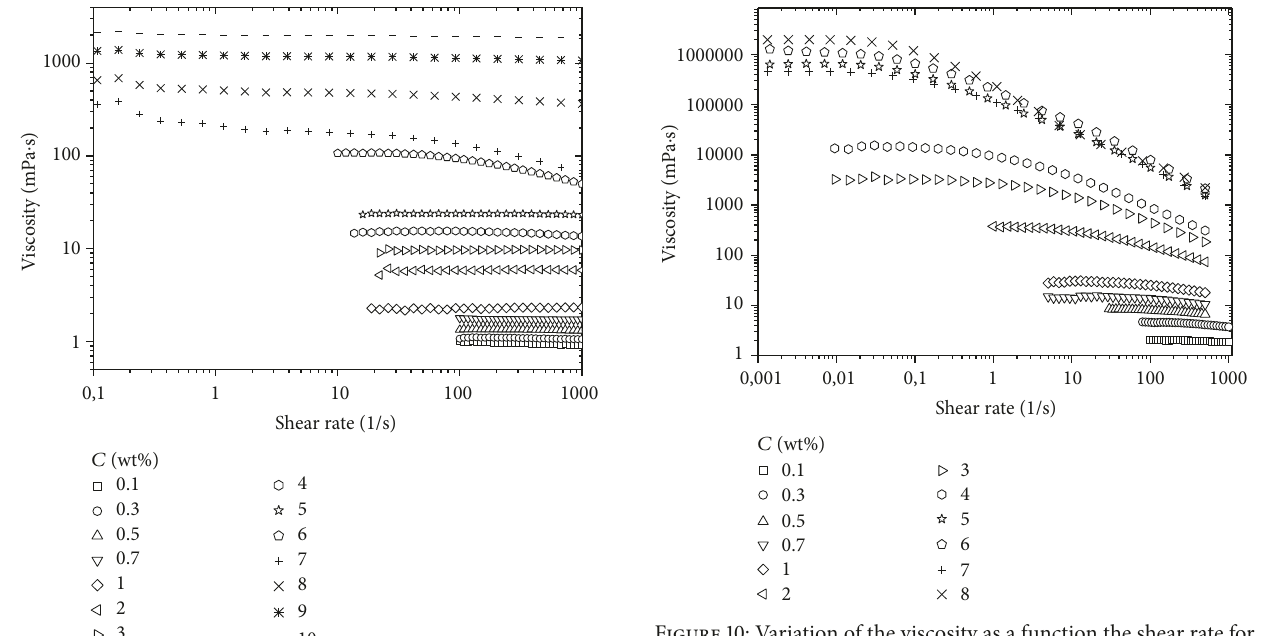
Figure 10: Variation of the viscosity as a function the shear rate for various concentrations of